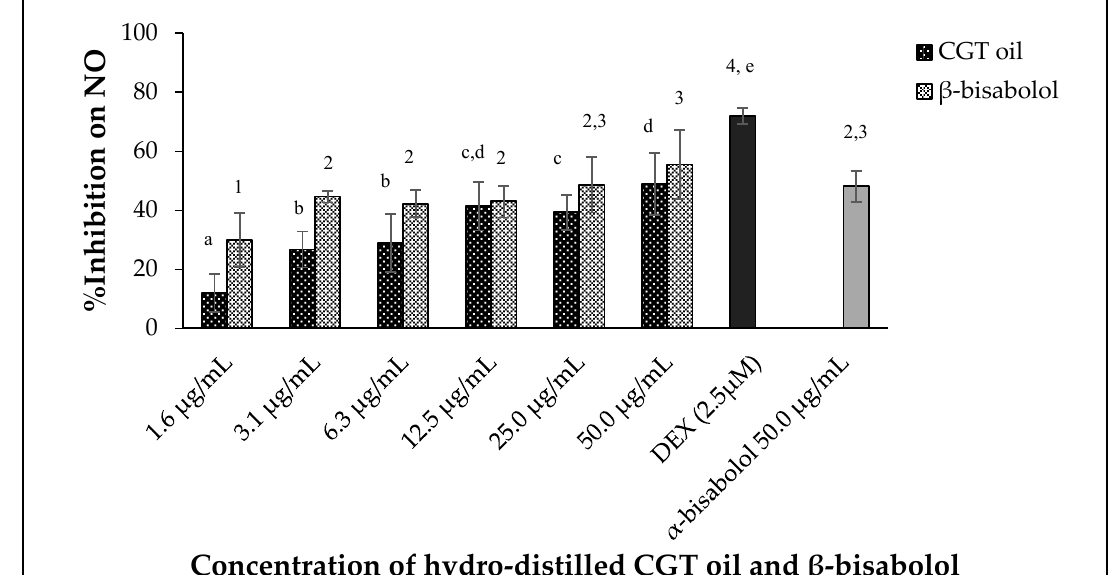
Figure 3. Effect of CGT oil and β -bisabolol on NO production in RAW 264.7 cells. RAW 264.7 cells were exposed to test extracts or compounds for 1 h and then induced with 100 ng/mL lipopolysac- charide (LPS) for NO production ( n = 3). Values are expressed as mean ± SD. Duncan’s multiple range test between average NO inhibition across the different concentrations indicates that dissimilar letters/numerals denote a significant difference ( p ≤ 0.05).